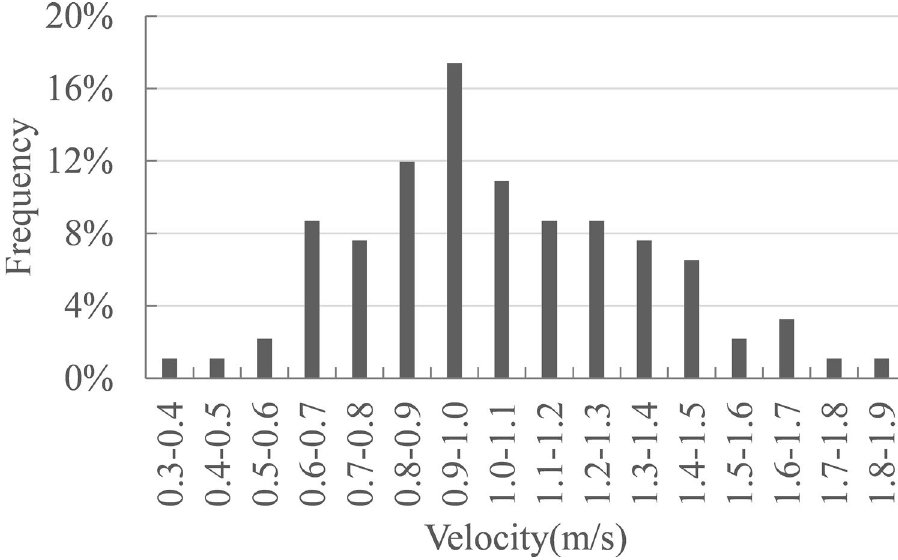
Figure 2. Plots of the frequency for the different flow velocity ranges of Chinese sturgeon signals.